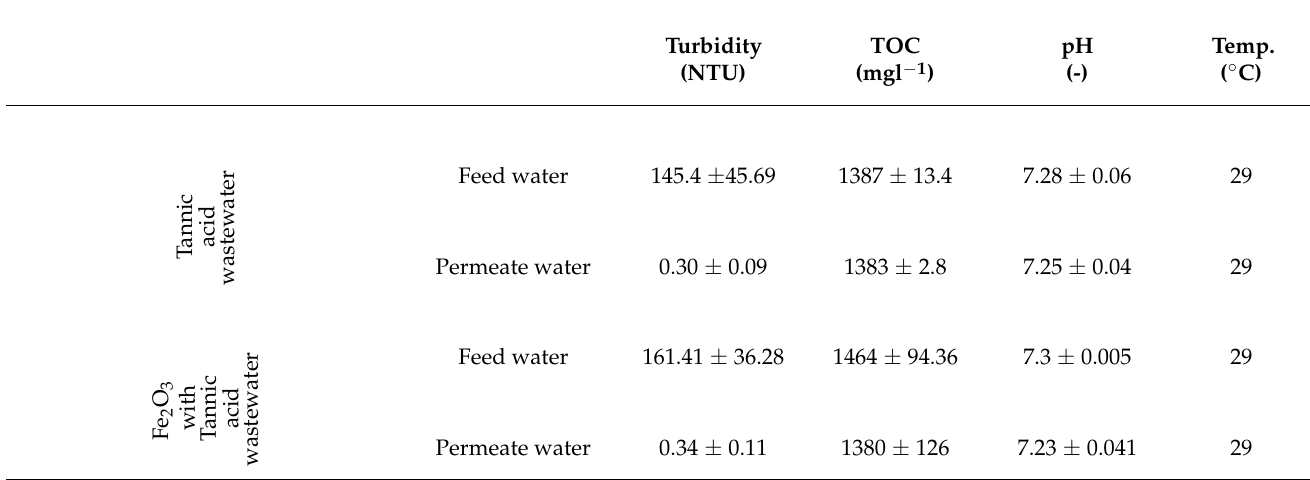
Table A3. Permeate water quality of